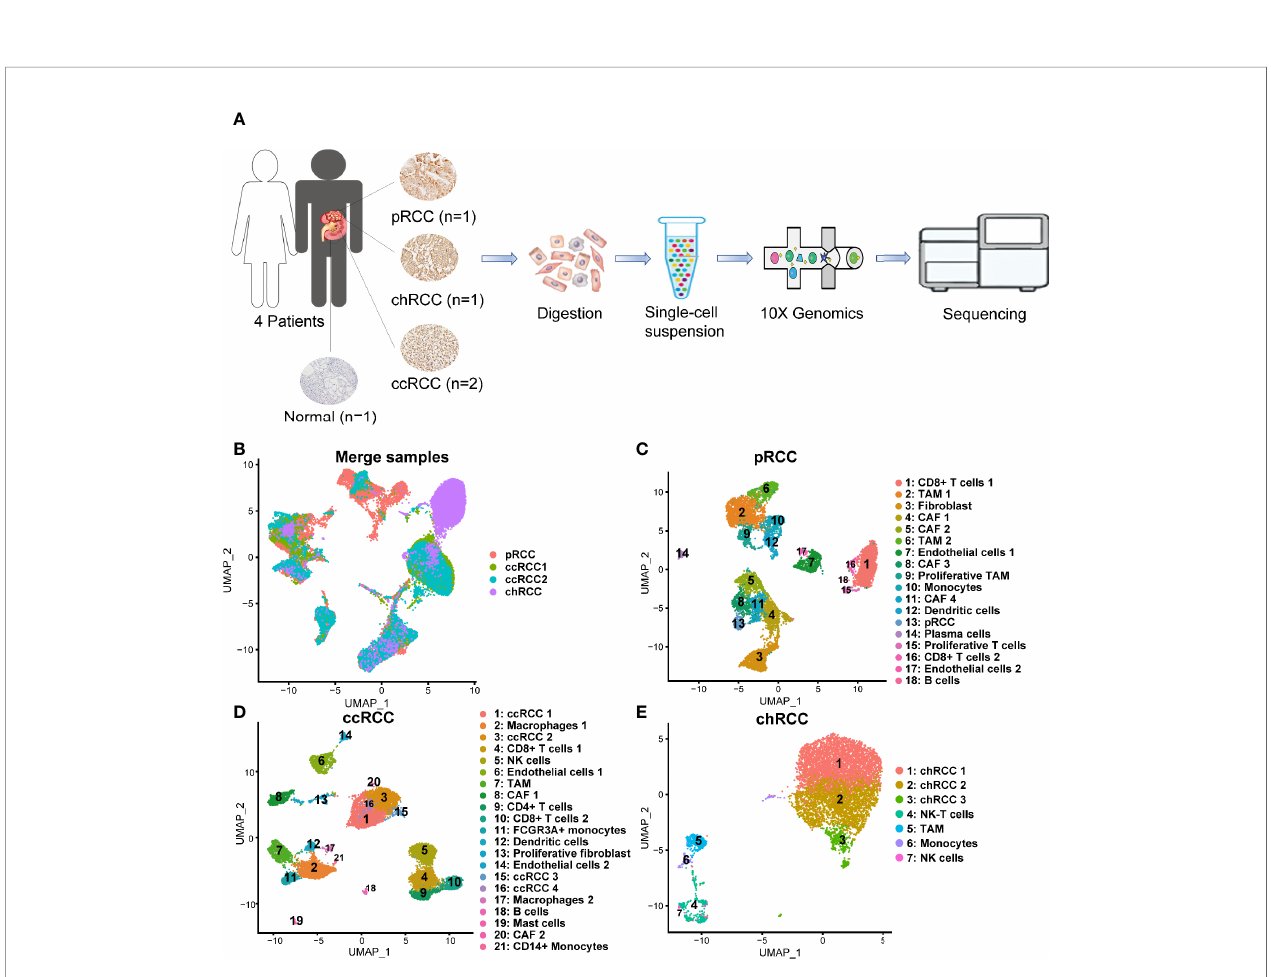
FIGURE 1 | Single-cell transcriptomic atlas of multiple pathologic types of RCC and human kidney. (A) Schematic of the overall study design. ScRNA-seq was applied to type 2 pRCC, ccRCC, chRCC and the normal kidney on 10x Genomics Chromium platform. (B) UMAP plot representation of 30,263 tumor cells from three pathological types of RCC. (C) Uniform manifold approximation and projection (UMAP) plot representation of 10,132 type 2 pRCC cells with 18 distinct cell types. (D) UMAP plot representation of 12,915 ccRCC cells from two different samples with 21 distinct cell types. (E) UMAP plot representation of 7,216 chRCC cells with seven distinct cell types.